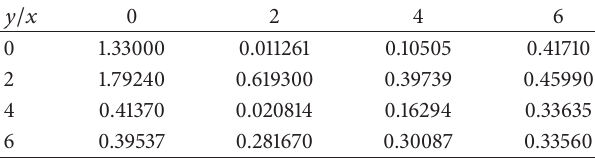
Table 3: Positive surface data from function 𝐹 1 (𝑥,𝑦)